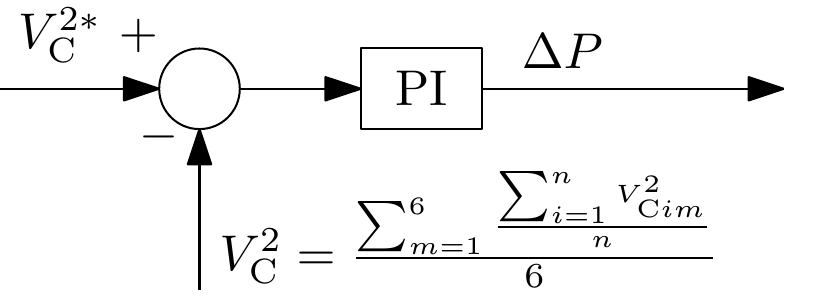
Figure 9. Virtual V 2